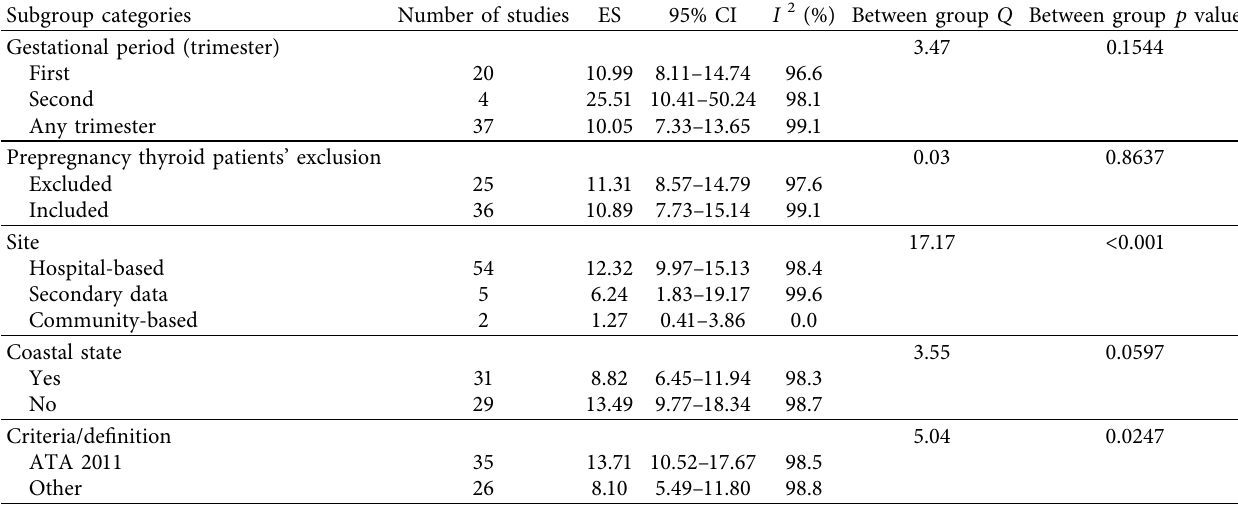
Table 2: Subgroup analysis of overall hypothyroidism estimates.